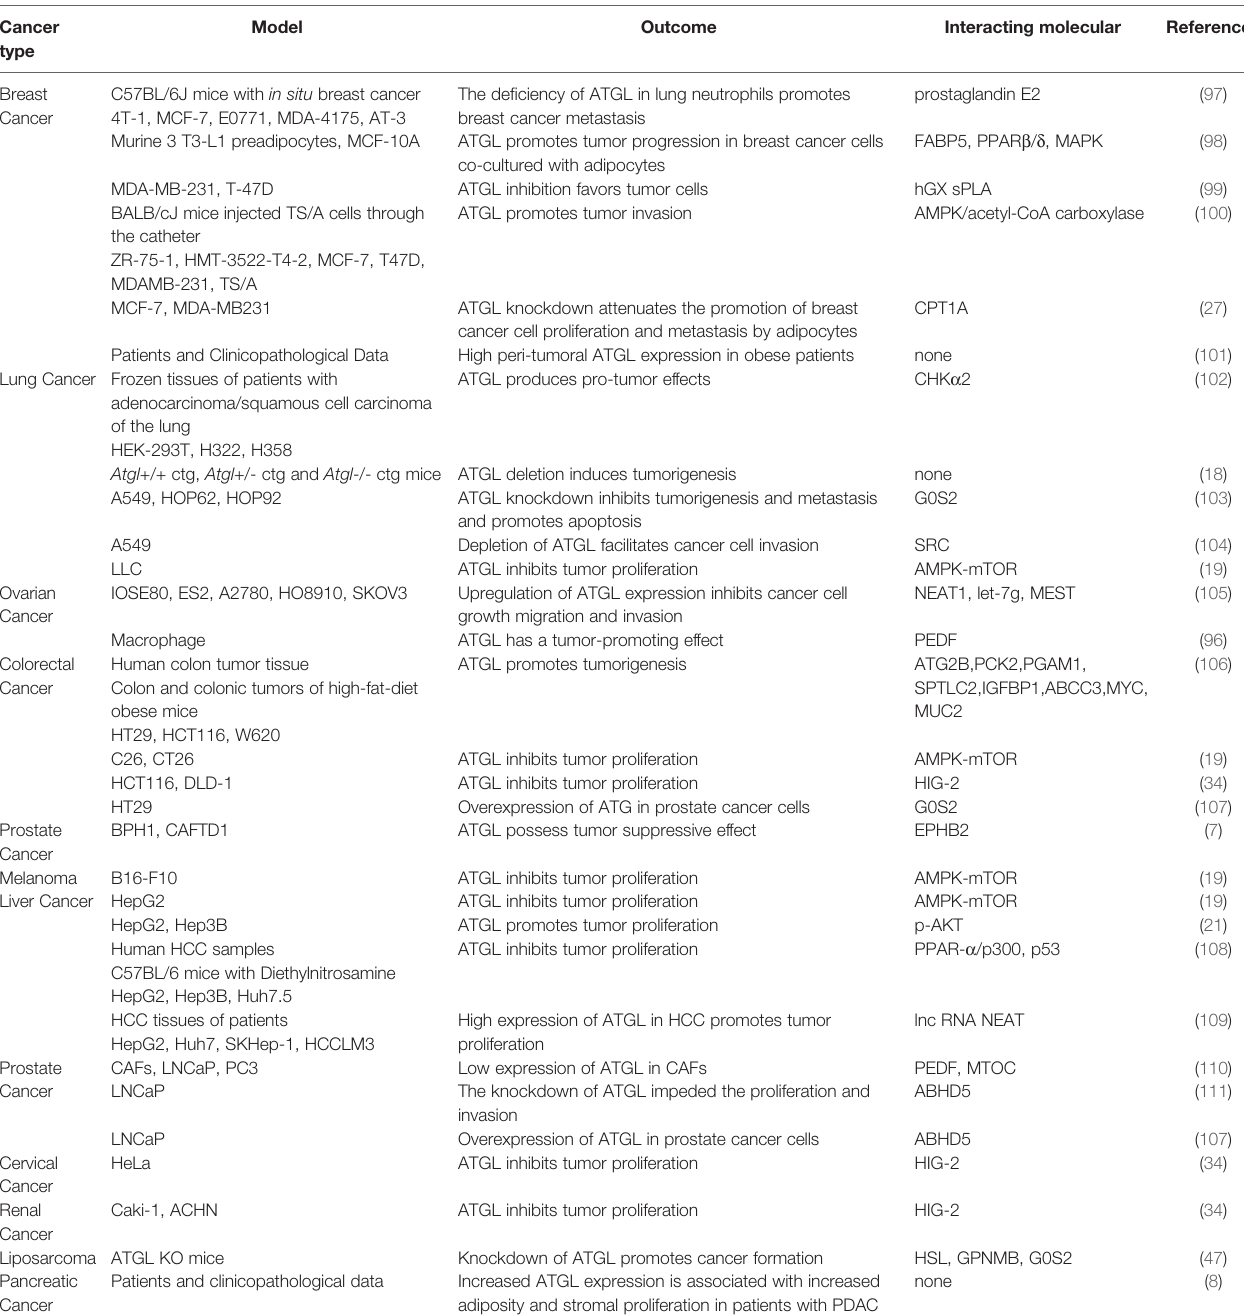
TABLE 1 | Role of ATGL in different tumors and the interacting